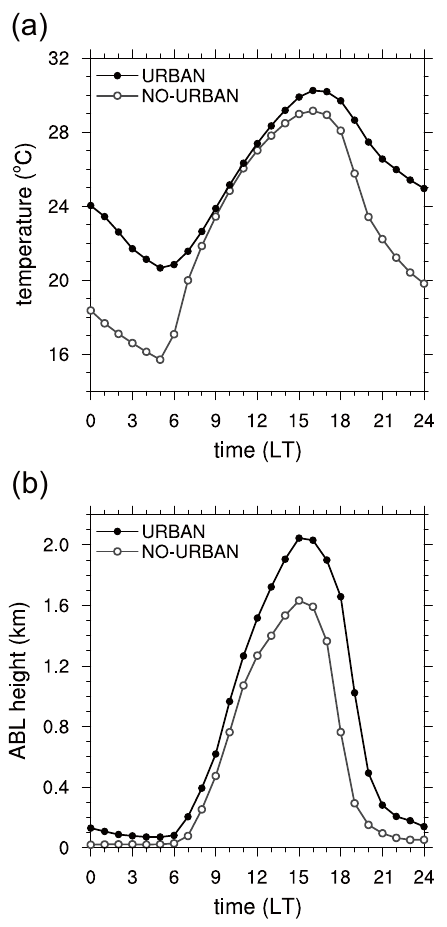
Fig. 4. Diurnal variations of (a) air temperature at 2 m and (b) at- mospheric boundary layer (ABL) height averaged over the urban analysis area in the URBAN and NO-URBAN